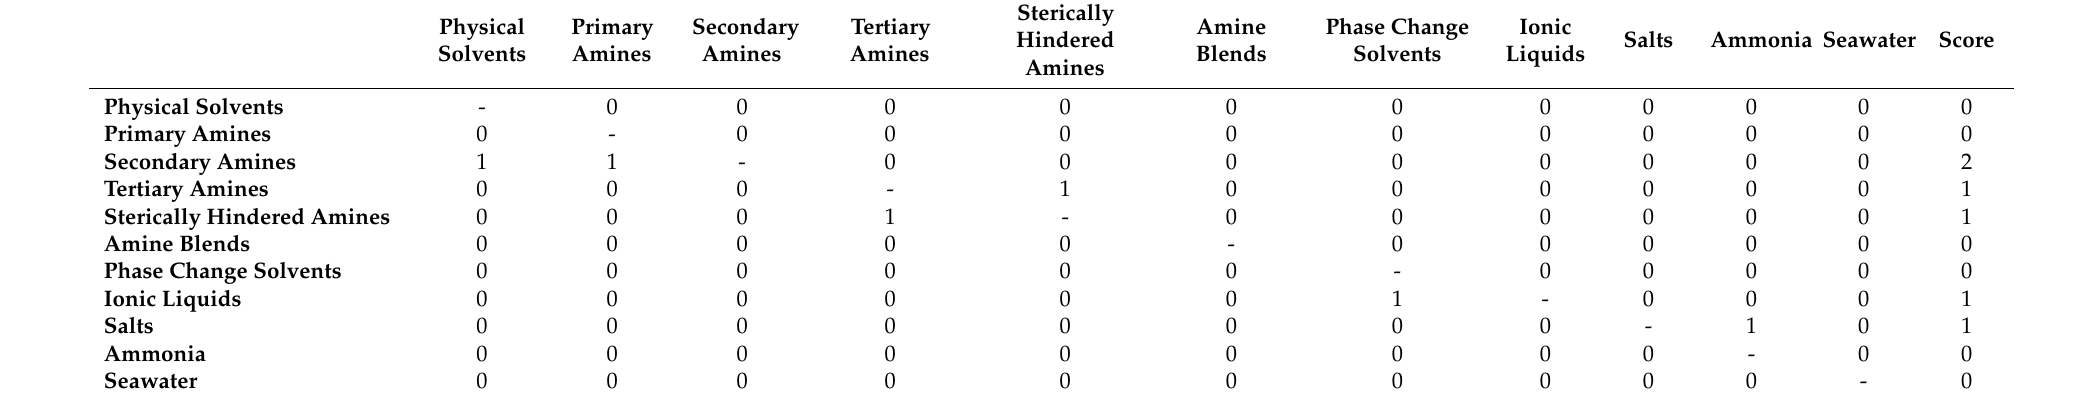
Table 4. Multi-objective assessment of the considered solvents using the KPIs with a criticality degree I.